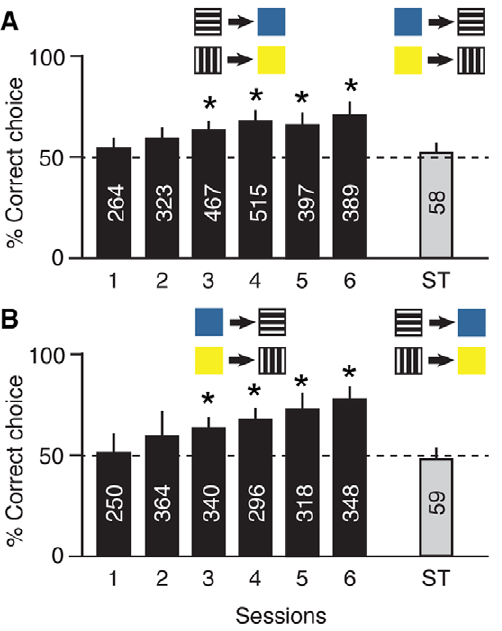
Figure 2. Learning of arbitrary relations in Apis mellifera honeybees. Black bars: mean percentage ( 6 s.d.) of correct choices in six rewarded training sessions of seven training blocks each, during which one group of 20 bees learnt the relations patterns-colours (A), and a second group of 20 bees learnt the relations colours-patterns (B). Grey bar: mean percentage ( 6 s.d.) of correct choices in an unrewarded symmetry test session (ST) during which the bees were presented with the stimuli in reverse order to the training sessions. Numbers inside bars indicate the total number of choices per session. Asterisks above columns indicate sessions in which the mean number of correct choices was significantly different to chance (50%) at P , 0.001.